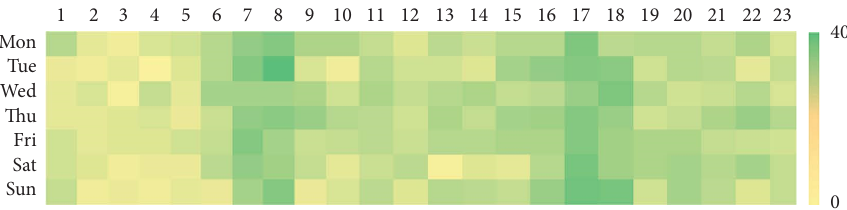
Figure 3: Dimensional distribution of accident time.